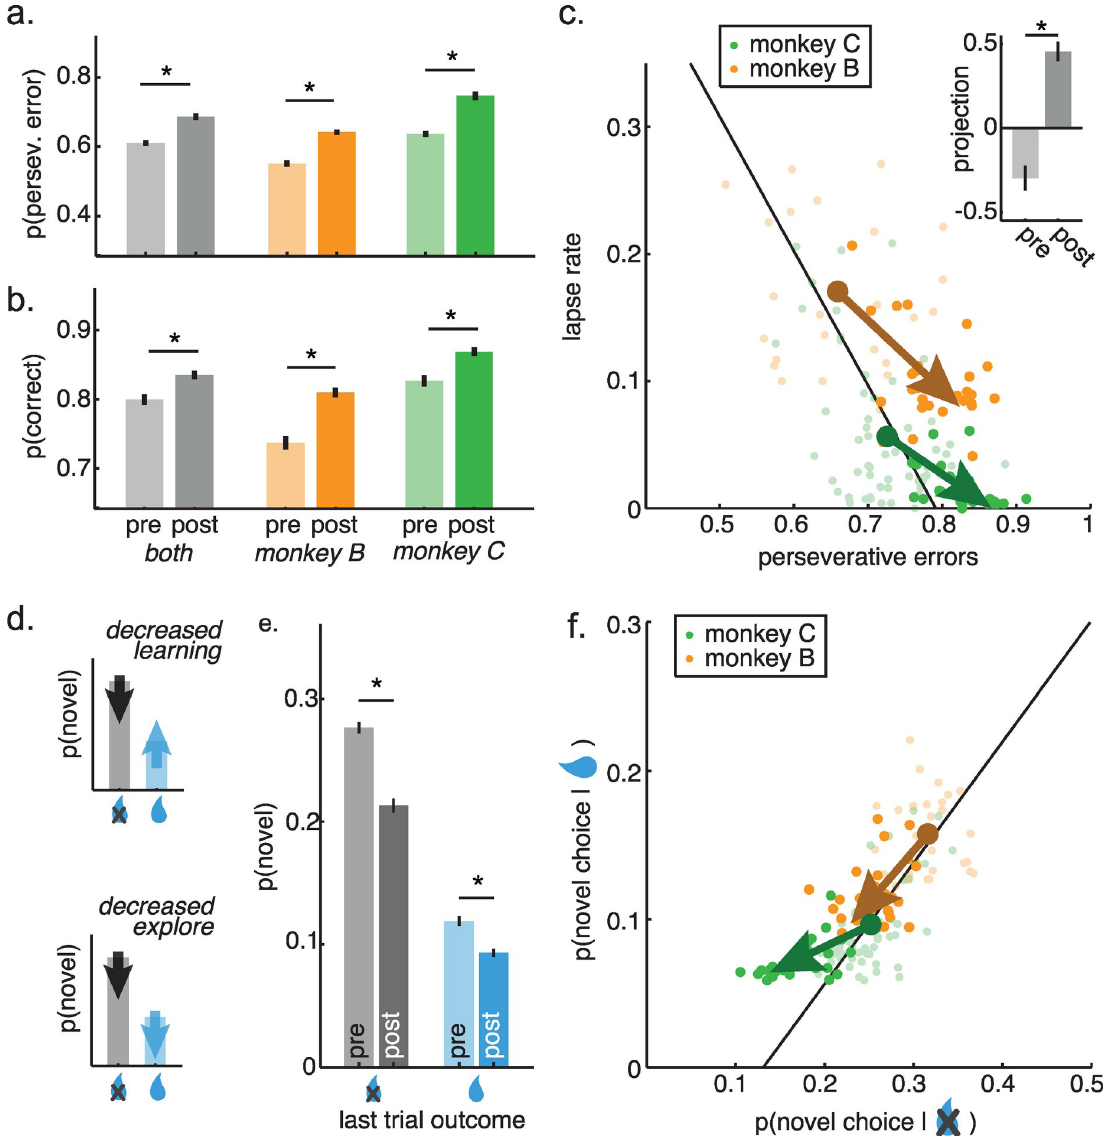
Fig 3. Changes in CSST behavior after cocaine administration. A) The probability of perseverative errors before and after cocaine treatment (before = light, after = dark), plotted together for both monkeys (gray) as well as separately for monkey B (orange bars) and monkey C (green). Error bars +/- SEM throughout and � p < 0.05, two-sample t-test. B) Same as A, for the percent of total correct trials in the pre- and post-cocaine sessions. C) Cocaine’s effects on the relationship between spontaneous lapses and perseverative errors. Same as 2E, but now illustrating post-cocaine sessions (dark) and pre-cocaine sessions (light). The vectors reflect the shift in the mean with cocaine for monkey B (orange) and monkey C (green). E) Cartoons illustrating different hypotheses. Top) If cocaine decreased learning rates, it would reduce effect of past outcomes on future choices, thereby reducing the difference in the probability of novel choices following trials that were or were not rewarded. Bottom) If cocaine decreases exploration, it would reduce all novel choices, without regard to previous reward outcome. E) Change in novel choice probability, plotted separately for reward omission (gray) and delivery (blue). Pre- cocaine = light, post cocaine = dark. F) Cocaine’s effects on the relationship between novel choices after reward delivery (ordinate) and omission (abscissa). Conventions the same as in